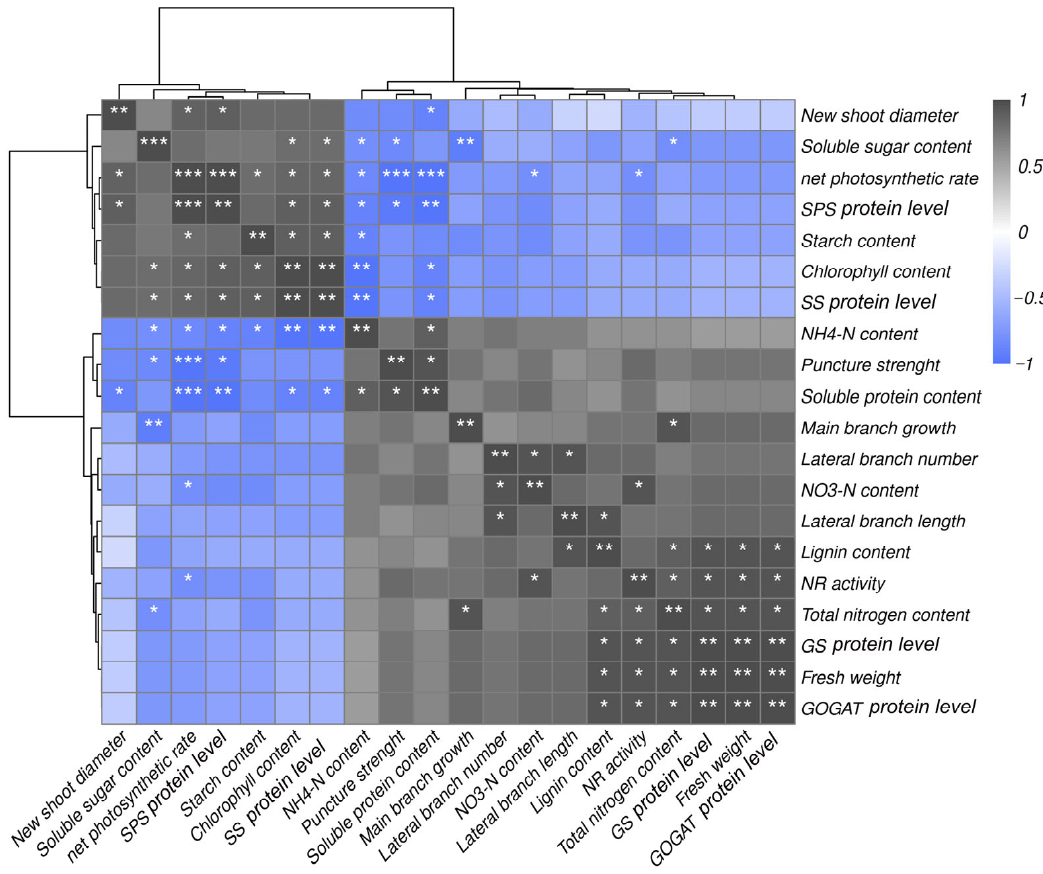
Figure 7. Correlation matrix among different physiological traits in peach tree. (Duncan test, Figure 7 . Correlation matrix among di ff erent physiological traits in peach tree. (Duncan test, * p ≤ * p ≤ 0.05, ** p ≤ 0.01, *** p ≤ 0.05, ** p ≤ 0.01, *** p ≤ 0.001)).